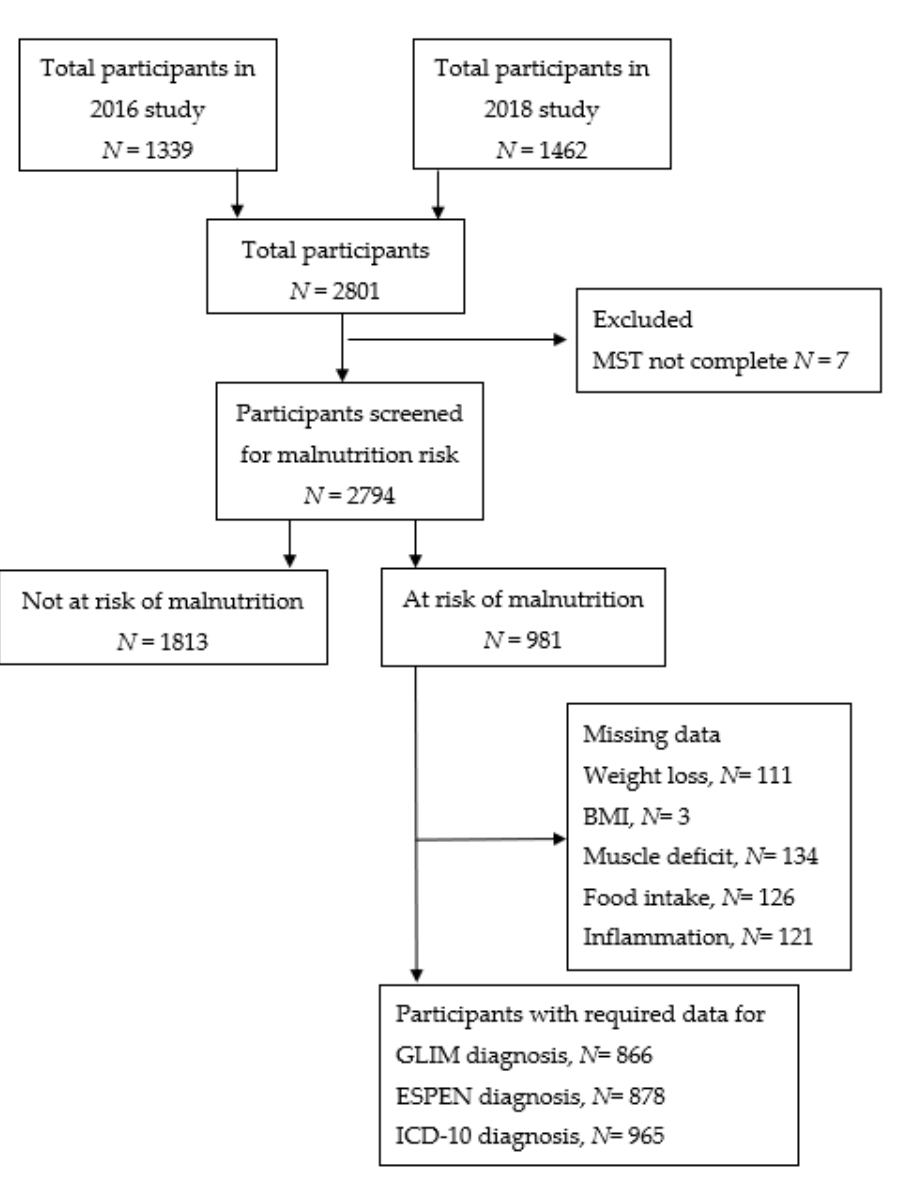
Figure 1. Participant flow diagram. Table 1. Demographic and clinical characteristics of participants ( N = Table 2. Malnutrition prevalence and assessment criteria according to GLIM, ESPEN and ICD-10 diagnostic criteria ( N = 2794).